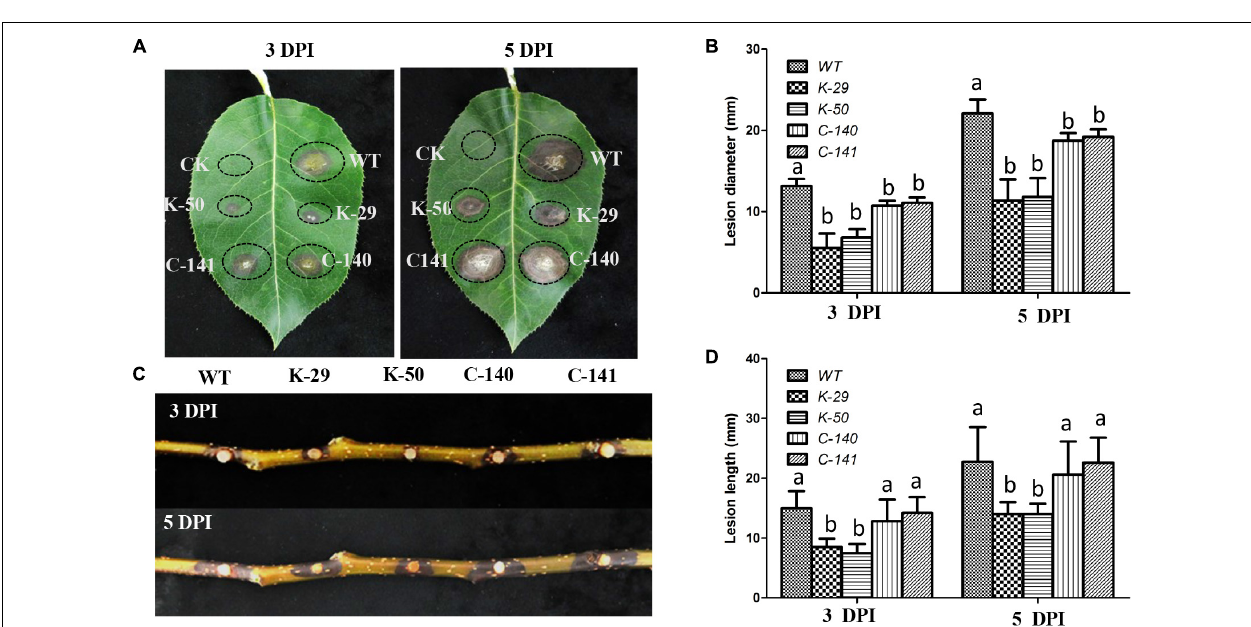
FIGURE 4 | Phenotypes of pear leaves and branches inoculated with the (cid:49) VpFSTF1 deletion mutant of V. pyri . (A) Abaxial surfaces of pear leaves were inoculated with mycelial agar plugs of WT, (cid:49) VpFSTF1 , and VpFSTF1 com strains. The inoculated leaves were incubated at 25 ◦ C in the dark. Lesions were photographed at 3 and 5 dpi, respectively. (B) Lesion diameters at inoculated sites on the leaves. (C) Wounded 1-year-old branches were inoculated with mycelial agar plugs of WT, (cid:49) VpFSTF1 , and VpFSTF1 com strains and incubated at 25 ◦ C in the dark. The lesions were photographed at 3 and 5 dpi, respectively. (D) Inoculated lesion lengths on pear branches. Bars indicate the standard deviations of means of three replicates. Different letters indicate significant differences ( P < 0.05, ANOVA).